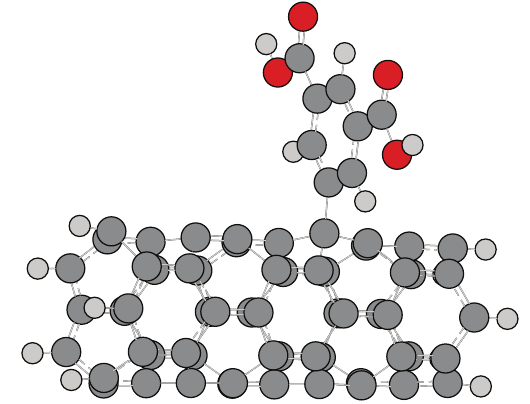
Figure 4: Optimized geometry of the finite (5, 0) zigzag SWCNT (C 60 H 20 ) with the isophthalic acid radical at the tube sidewall. Gray color depicts carbon atoms; light gray is hydrogen and red is oxygen.